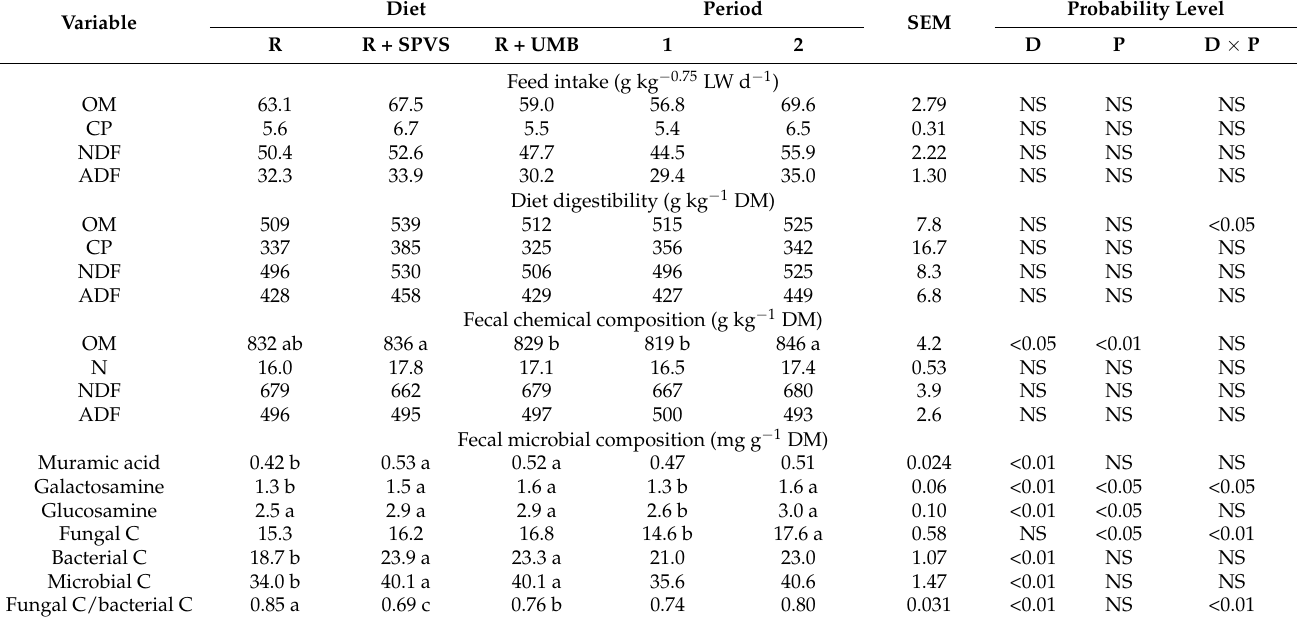
Table 3. Feed intake, diet digestibility and fecal concentrations of organic matter (OM), crude protein (CP) or N, neutral detergent fiber (NDF), acid detergent fiber (ADF), and amino sugar components of fungal and bacterial biomass in feces of Holstein × Boran heifers offered roughage alone (R; wheat straw and Rhodes grass hay), or R supplemented with sweet potato vine silage (R + SPVS) and urea-molasses blocks (R + UMB); standard error of the mean (SEM); probability levels obtained with lme